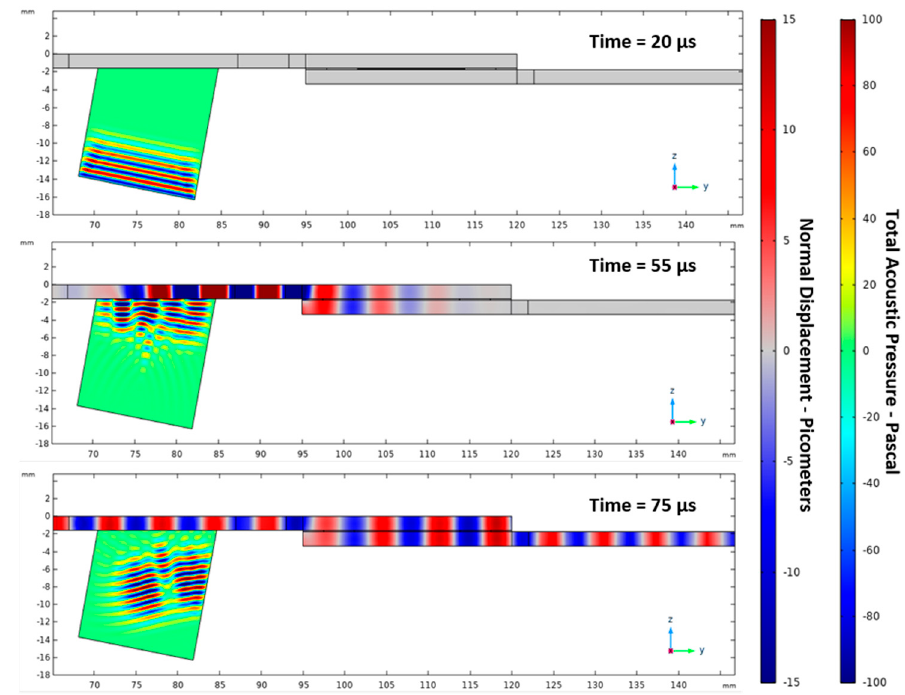
Figure 15. Snapshots of the normal displacements from COMSOL simulation (side view) of the no defect model at time instants 20 µ s, 55 µ s, and 75 µ s showing propagation of A0 mode.